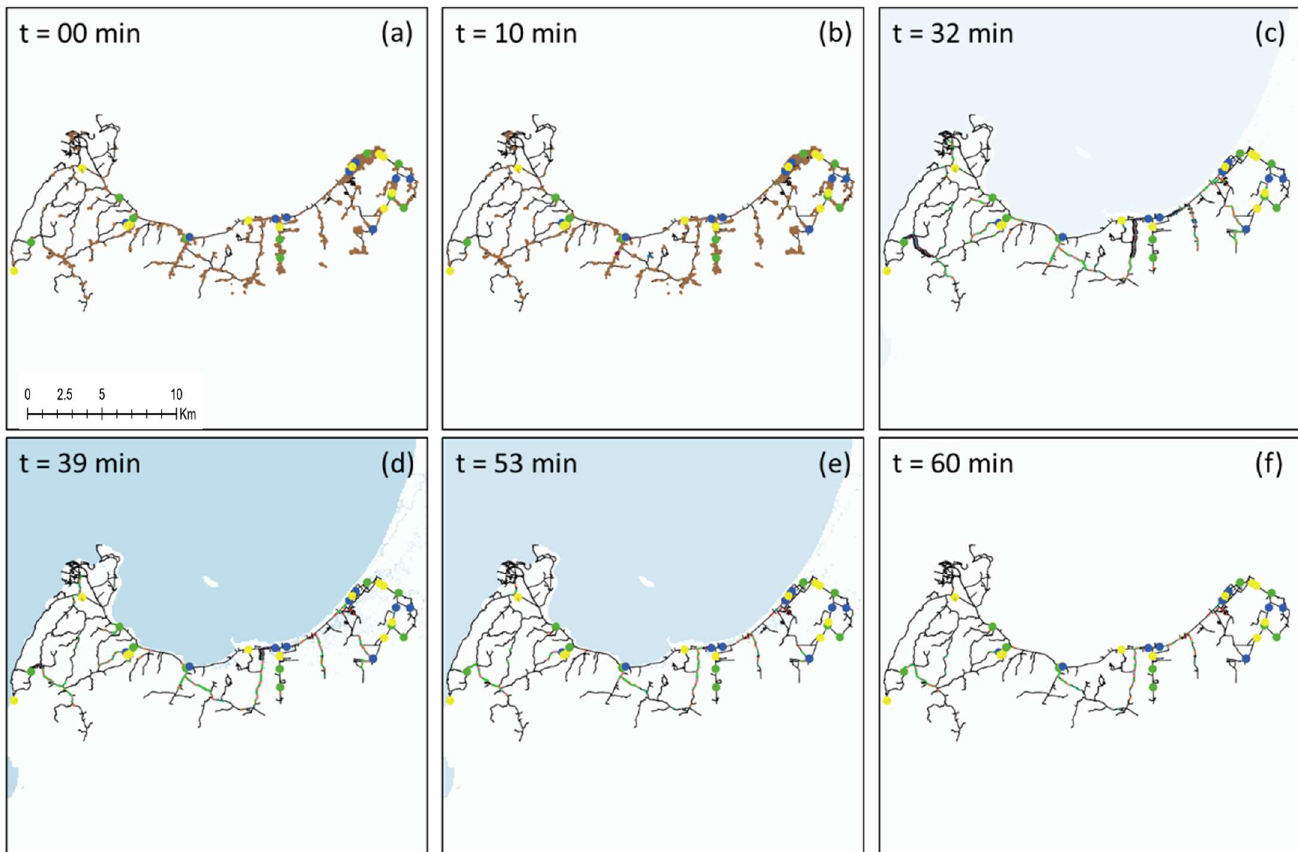
Figure 3. Model behaviour overview at different simulation times, t = 0 (a), 10 (b), 32 (c), 39 (d), 53 (e), and 60 (f) minutes, with the initial population (agents) indicated by brown circles, schools in yellow, worship facilities in green, government offices in blue, and VESs in purple.